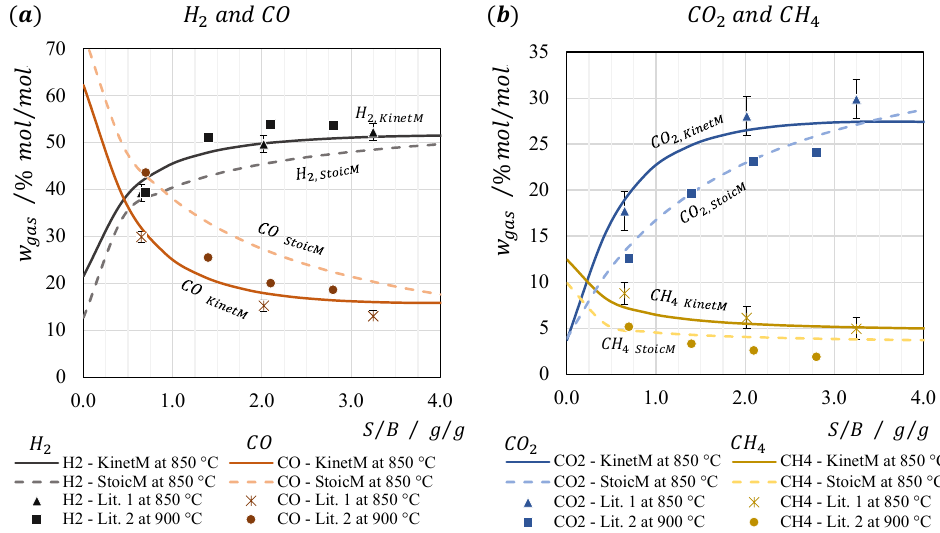
Figure 3. Effect of S / B on the dry syngas composition at T = 800 °C, comparing the results of KinetM (continuous lines) and StoicM (dashed lines) with results from the literature: ( a ) H 2 and CO. ( b ) CO 2 and CH 4 . Lit. 1 and Lit. 2 results are taken from [18,46],